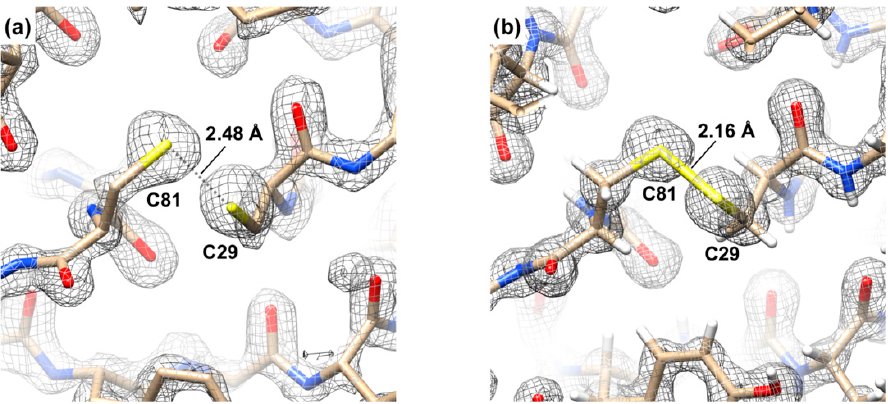
Figure 6. A fragment of the sigma-A weighted 2mFo-DFc electron density of the 1.6 Å resolution gp61.3 SeMet crystal structure ( a ) and that of the 1.15 Å resolution gp61.3-gp5Lys crystal structure ( b ). The map is contoured at 2 standard deviations above the mean.